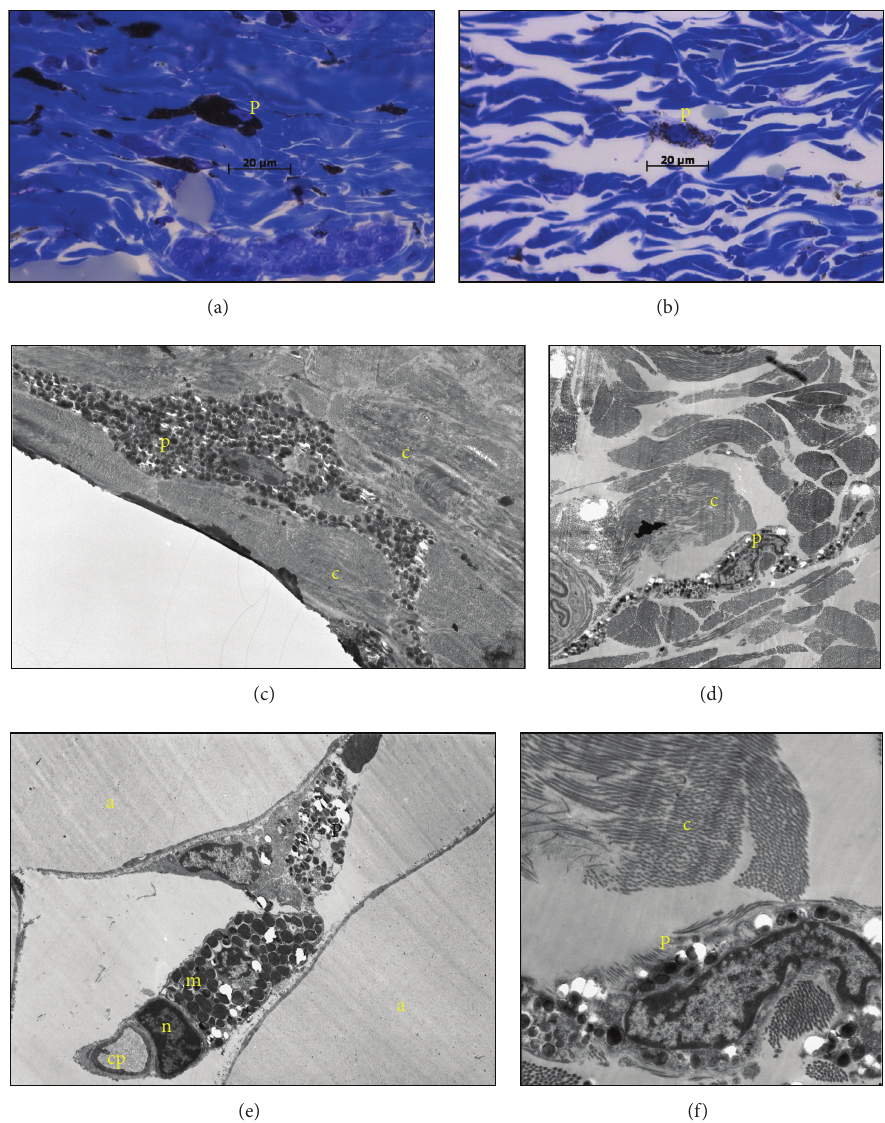
Figure 3: Pigment-containing cells in the four-striped mouse skin. (a), (c), and (e) from adult skin and (b), (d), and (f) from juvenile skin. Pigment-containing cell (p) is interspersed between connective tissue in (a)–(d). Pigment-containing granules are visible in the cell cytoplasm surrounding the nucleus (n) and in the long cytoplasmic extensions (e) and they also lie between adipocytes (f). (a) and (b) are photomicrographs of adult and juvenile dermis, respectively. (c) is electron micrograph of adult dermis; (d) is juvenile dermis; (e) adult hypodermis, and (f) juvenile dermis. a: adipocyte; c: collagen; cp: capillary; m: mast cell. (a) and (b) are Toluidine blue staining and scale bar = 1 𝜇 m. Scale bar: (c) = 0.33 𝜇 m; (d) = 0.5 𝜇 m; (e) = 0.33 𝜇 m; (f) = 0.17 𝜇